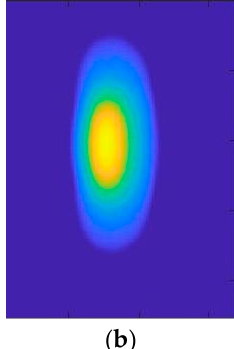
Figure 1. Ping-pong ball granular flow experiments undertaken at the Miyanomori ski jump hill in Hokkaido, Japan [6–8]. ( a ) A ping-pong ball flow shortly after release. ( b ) The final deposit shape of the ping-pong ball flow, which looks like a crescent bending downslope.